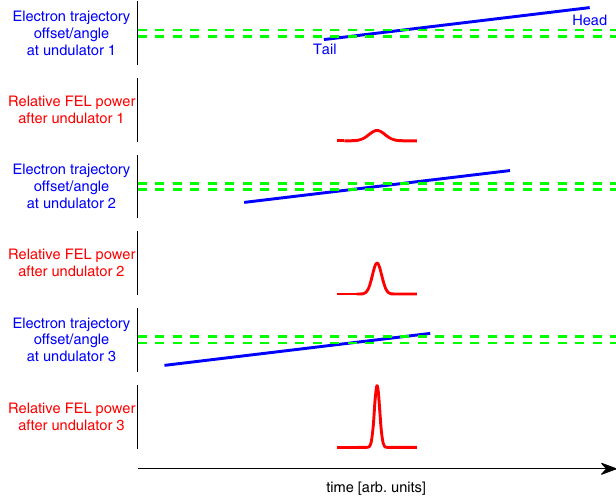
FIG. 2. Working principle of the proposed scheme for an example case with three undulator sections. The horizontal axis for all the plots is time in the reference system of the radiation field. The dashed green lines define the GTR outside of which the electron beam cannot significantly amplify the XFEL